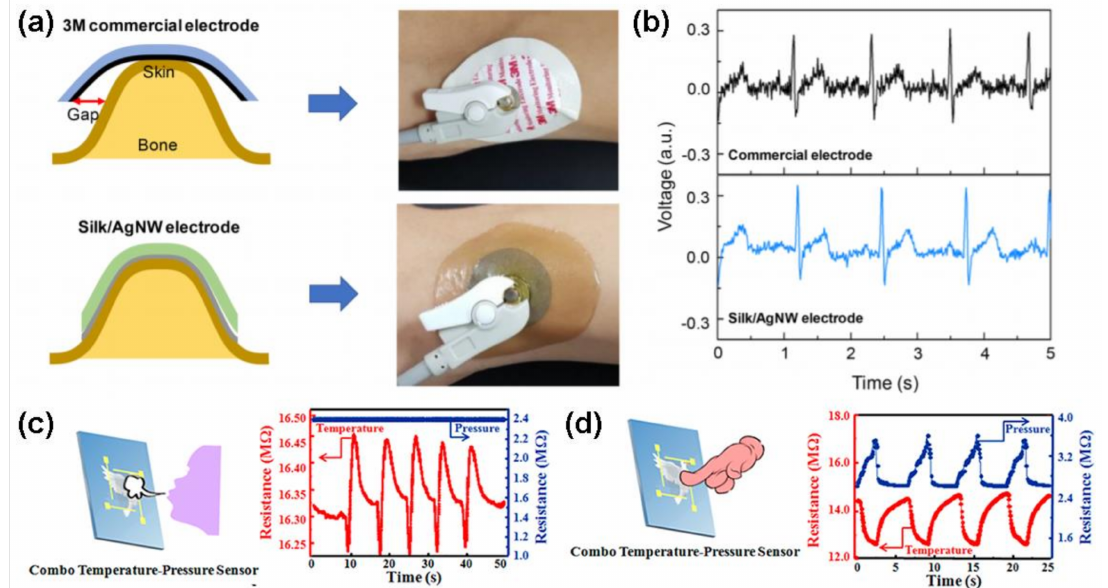
Figure 3. ( a ) Schematics and photos of conformal attachment of AgNW/silk electrode, ( b ) ECG signals captured by electrodes attached to bump of the wrist. The nonconforming nature of the commercial electrode induces a large amount of noise in the signal. Reproduced with permission from [51]. Copyright 2018, American Chemical Society. Schematic illustration and simultaneous sensing performance of the combo e-skin sensor under various stimuli ( c ) exhaling stimulus and ( d ) finger pressing stimulus. Reproduced with permission from [52]. Copyright 2017, American Chemical